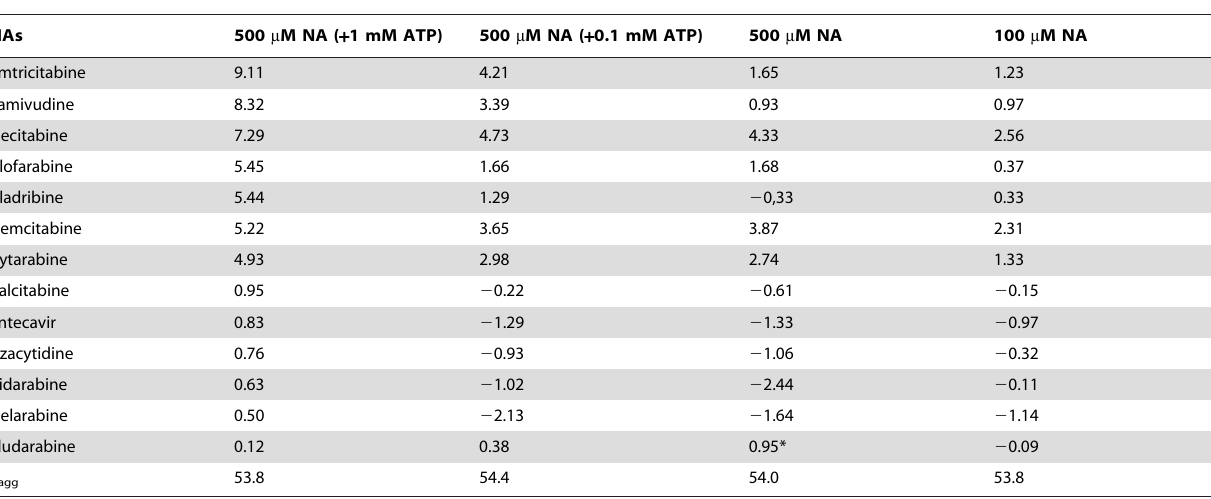
Table 2. Mean D Tagg ( u C) for